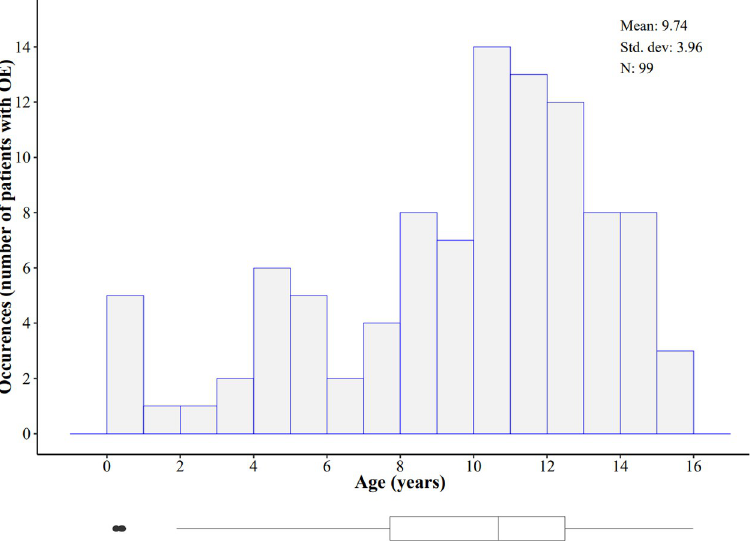
Fig 2. Age distribution of patients. Histogram and boxplot representing the age distribution of the patients with orchiepididymitis included in the study.